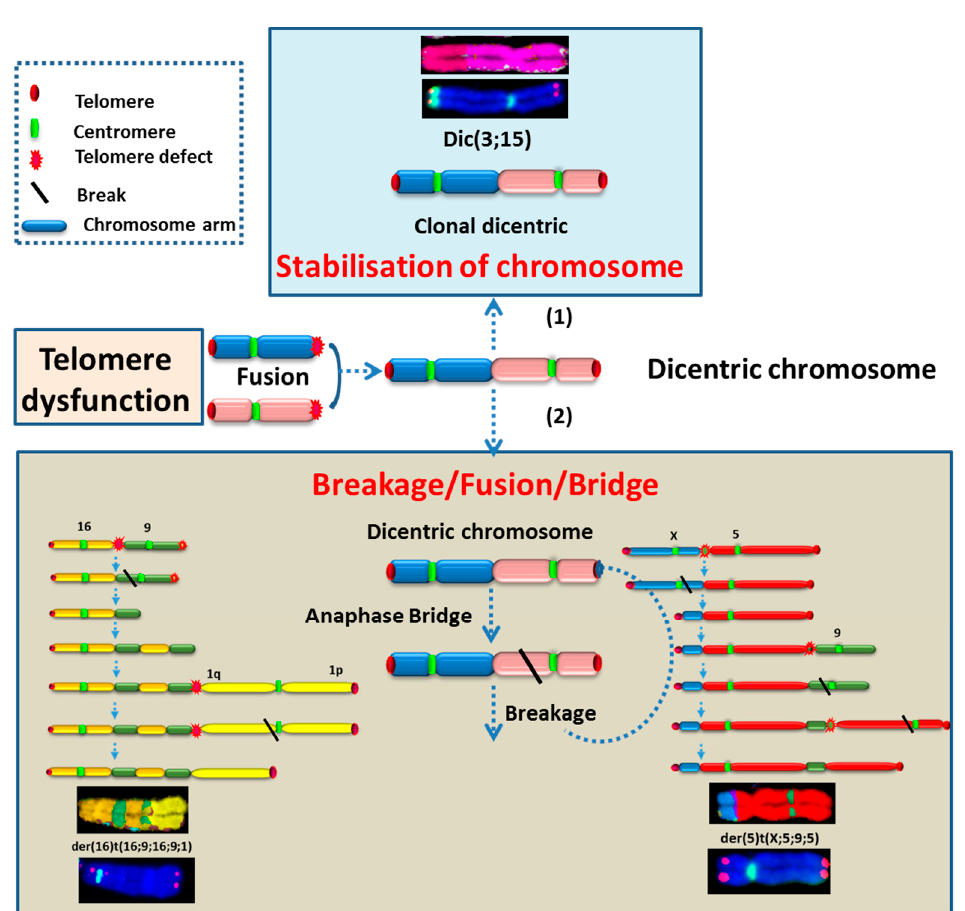
Figure 13. Schematic representation of genome rearrangements induced by telomere dysfunction and dicentric chromosome formation: (1) stabilization of dicentric chromosome and the formation of clonal dicentric, for example dic(3;15) (2) B/F/B cycles and the putative steps for the derivation of the der(16)t(16;9;16;9;1) and der(5)t(X;5;9;5) via B/F/B cycles were represented.